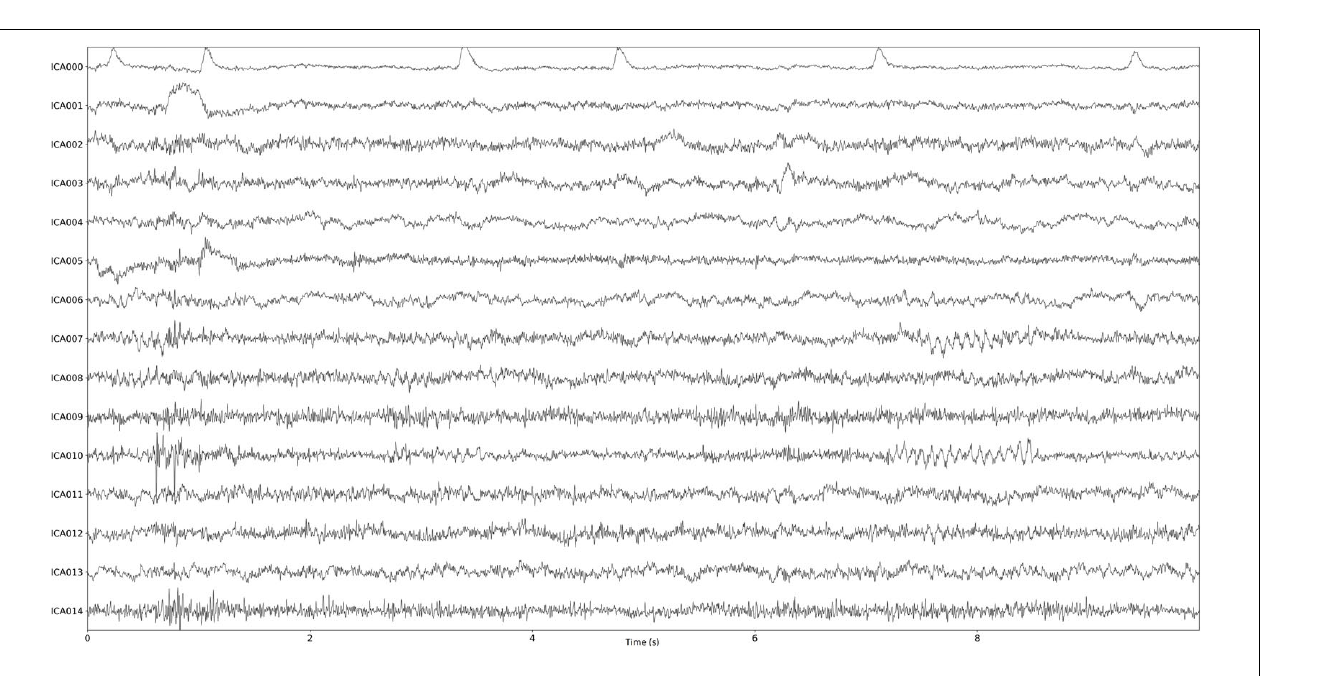
FIGURE 7 | Close up on the eye blink artifact.